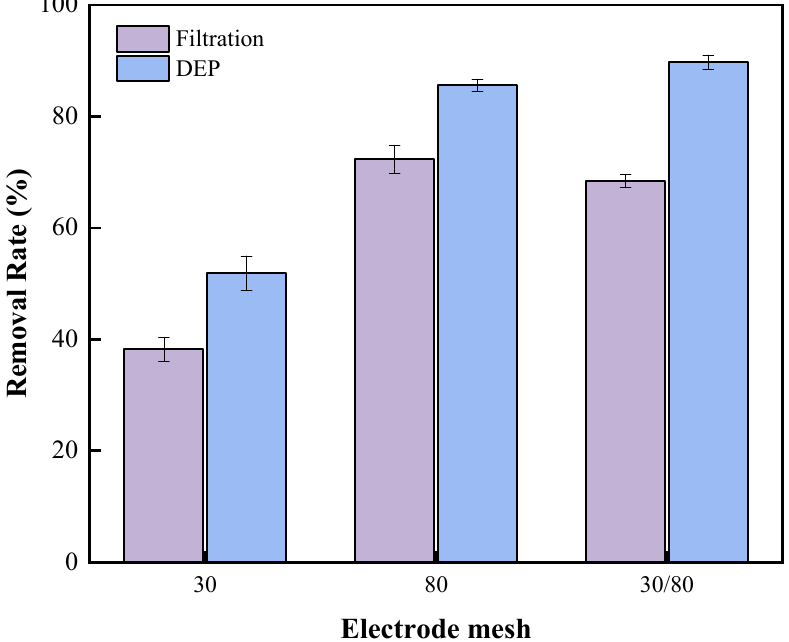
Figure 5. Comparison of the effect of electrodes filtration and DEP with different mesh size.